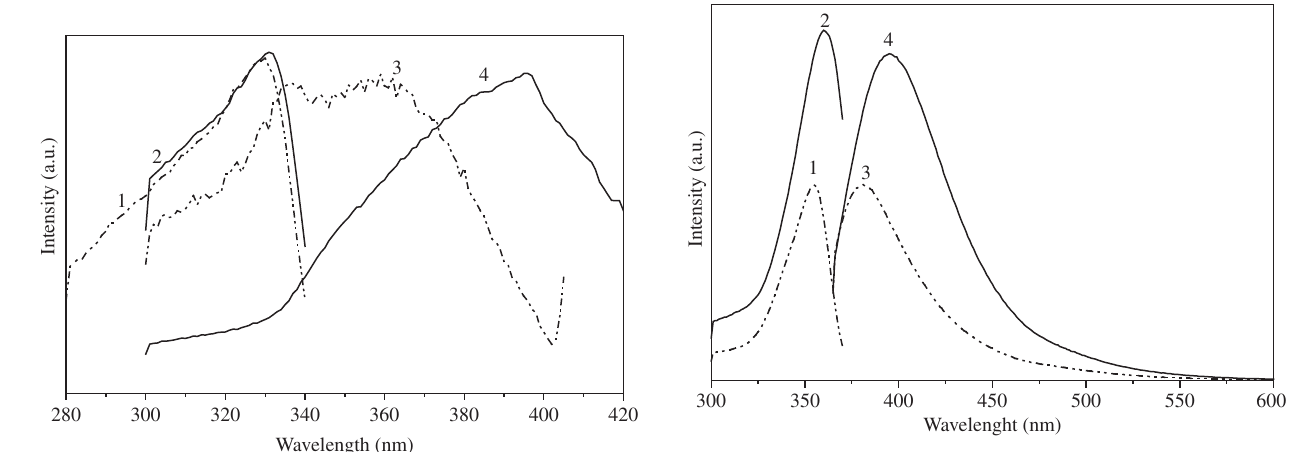
Figure 6. Excitation and fluorescence spectra of the stoichiometric DGE- BA/DDS mixture 100:30 m/m: excitation monitored at 1) 385 nm and 2) 393 nm and fluorescence excited at 3) and 4) 350 nm. Dashed lines refer to the DGEBA/DDM/9AA mixture before heat-treating; full lines refer to the